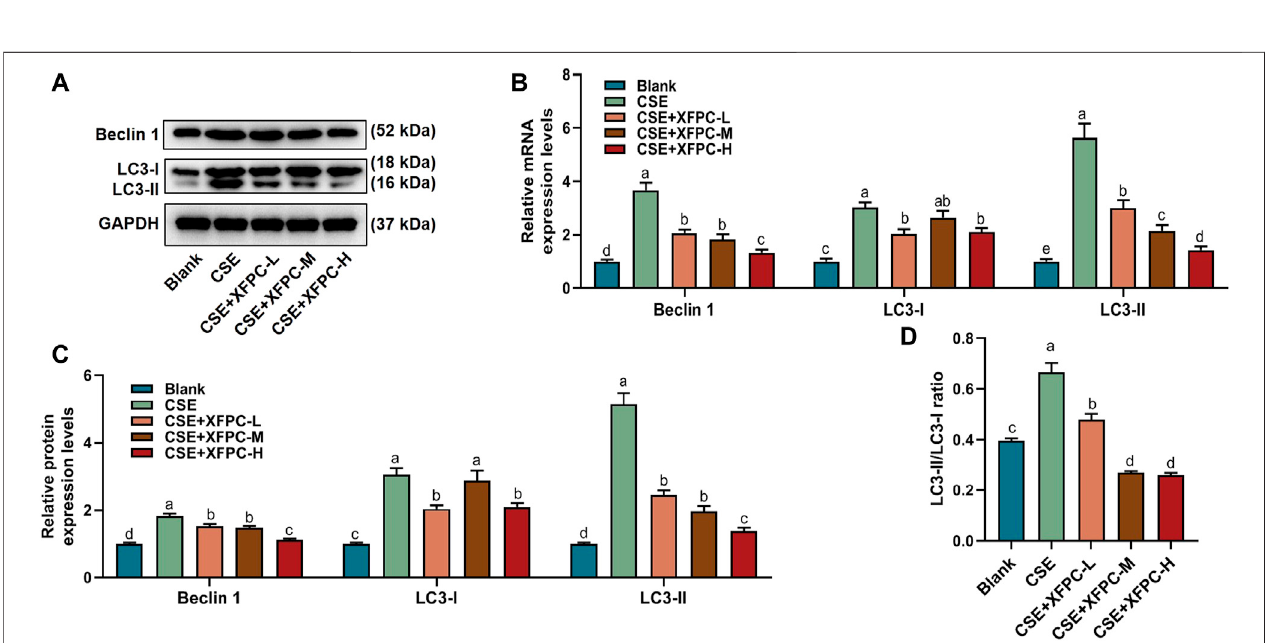
FIGURE 3 | XFPC could inhibit expression of autophagy in CSE-HBE cell model. (A) The protein level of autophagy indicators, Beclin 1, LC3-I, and LC3-II were detected by western blot in HBE cells which were treated with CSE and different concentrations of XFPC. (B) Quanti fi cation of mRNA expression level of Beclin 1, LC3-I and LC3-II. (C) Quanti fi cation of protein levels of Beclin 1, LC3-I and LC3-II from western blot of panel (A) . (D) The relative protein expression level of LC3-II compared with LC3-I from western blot of panel (A) . XFPC, Xuanfei Pingchuan Capsules; CSE, cigarette smoke extract; HBE cells, human bronchial epithelial cells; LC3, microtubule-associated protein light chain